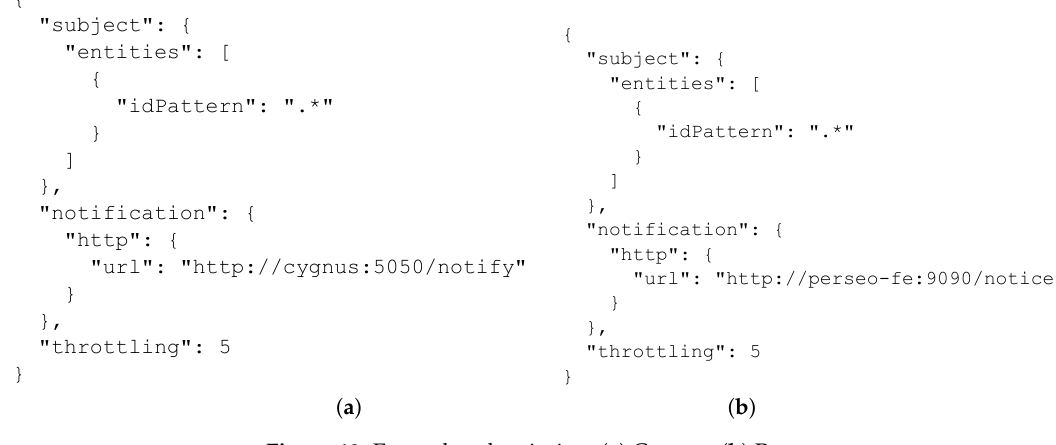
Figure 10. Example subscription: ( a ) Cygnus; ( b ) Perseo. Table 2. Description of the subscription fields.